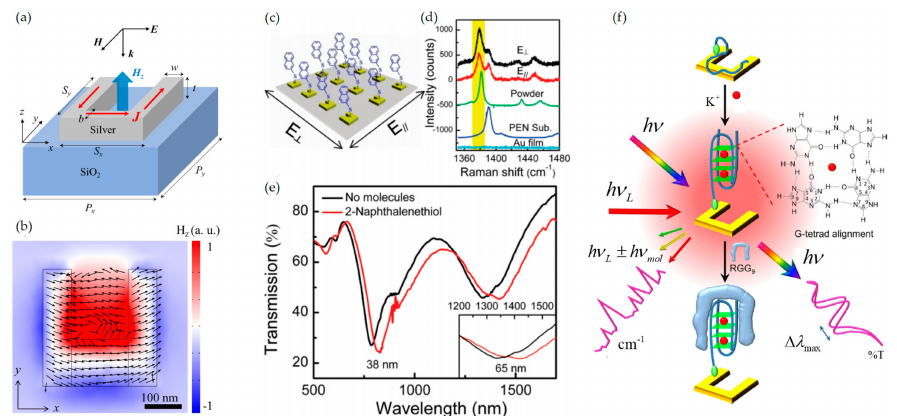
Figure 2. ( a ) A schematic illustration of SRR. Structural parameters are described. Magnetic field is generated along z -axis when x -polarized incidence is coming along z -axis; ( b ) H z -field profile on resonance. It shows the generation of current loops (black arrows). The resonance conditions are as follow: λ = 1300 nm, S x = S y = 320 nm, P x = 504 nm, P y = 480 nm, w = 80nm, t = 30 nm, b = 128 nm; ( c ) A schematic illustration of chemical sensor of 2-naphtalenethiol using MM; ( d ) Raman spectra of 2-naphtalenethiol on various substrate environments; ( e ) Transmission spectra with and without 2-naphtalenethiol. The inset is the zoom-in view of the spectra around the magnetic resonance mode. ( f ) Schematic configuration of vis-NIR SRR MMs for detection and identification of biomolecules. This SRR sensor was designed to functionalize with AS1411, an effective anticancer drug. Parts ( c – e ) are reprinted with permission from Reference [84]. Copyright (2011) American Chemical Society. Part ( f ) is reprinted with permission from Reference [85]. Copyright (2013) American Chemical Society.